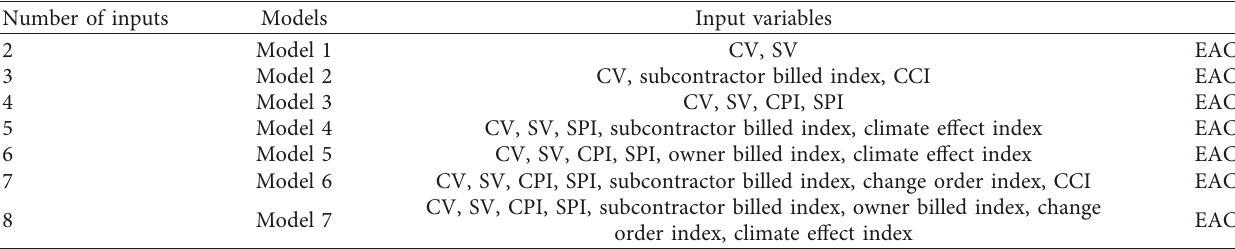
Table 5: The input combination attributes used to determine the value of the EAC using the BF-DNN model. Number of inputs